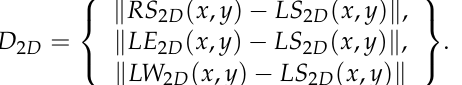
A 3D generator unit was used to combine the information of 𝐽 (cid:2870)(cid:3005) and 𝑀 (cid:3017) [23]; 𝐽 (cid:2870)(cid:3005) assists the generator to determine the depth coordinates of the images from the distribu- tion of the point cloud data, which is denoted by 𝐽 (cid:2871)(cid:3005) . The same feature selection as for the 2D images was adapted, with the joint of the left shoulder used as the reference point to